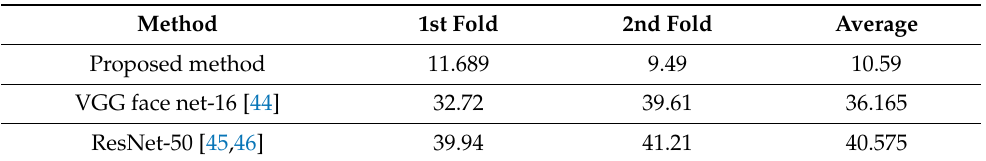
Table 16. Comparisons of EERs obtained using proposed method and state-of-the-art face recognition methods (unit: %).